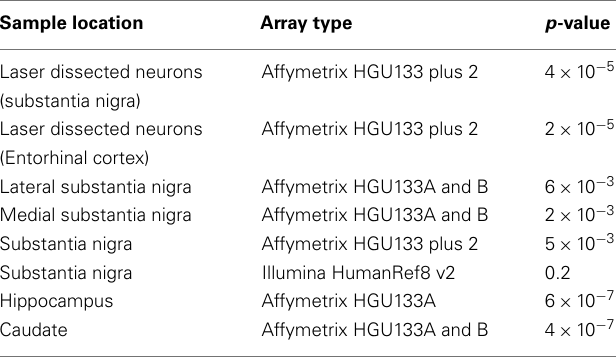
Table 6 | Lower X:Autosome ratio for microglia than neurons and whole